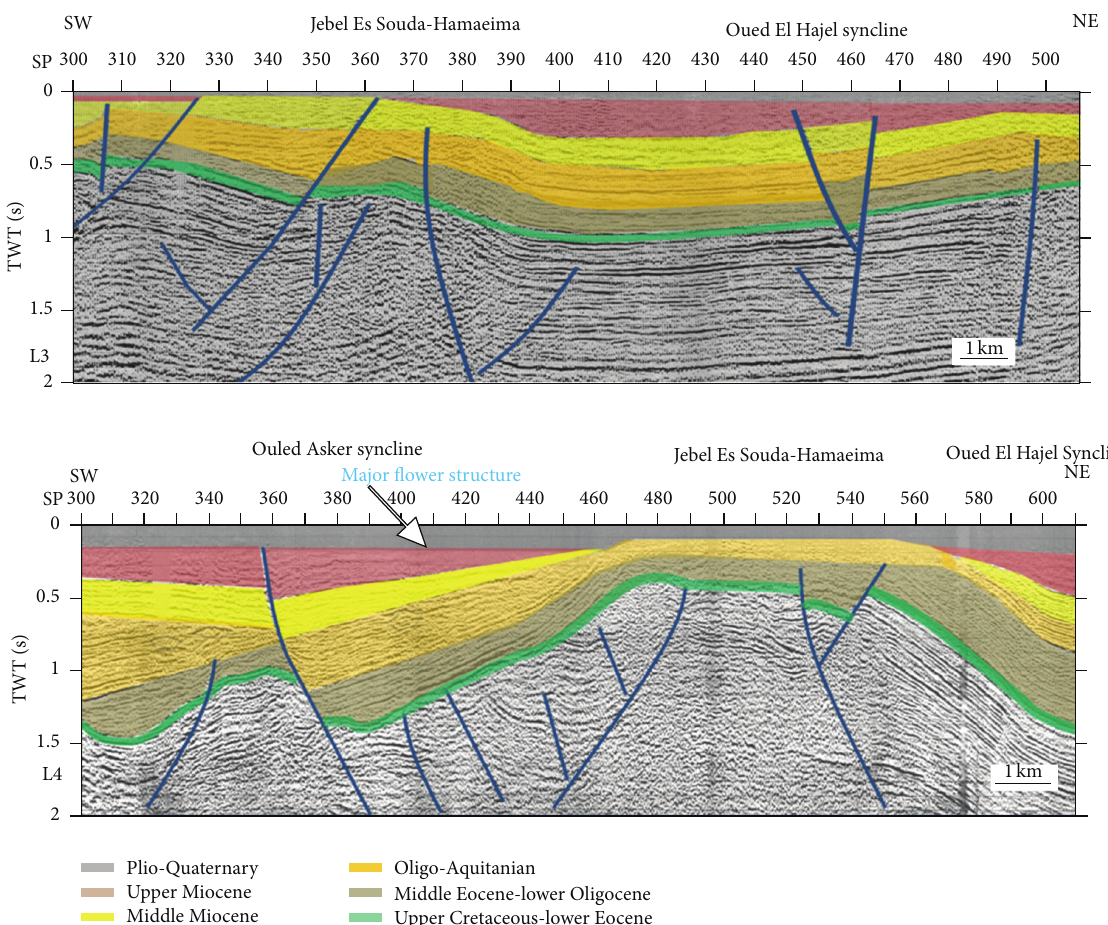
Figure 11: Interpreted seismic lines across the study area (L3 and